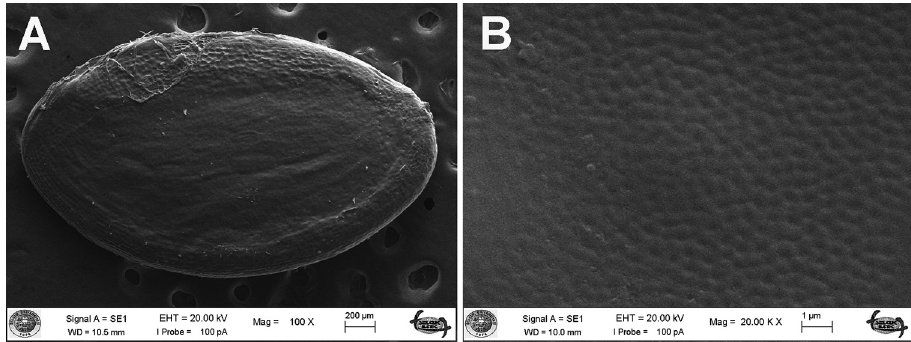
Figure 4. Scanning electron micrographs of seeds Linum aksehirense species A general view and B surface sculpturing pattern.